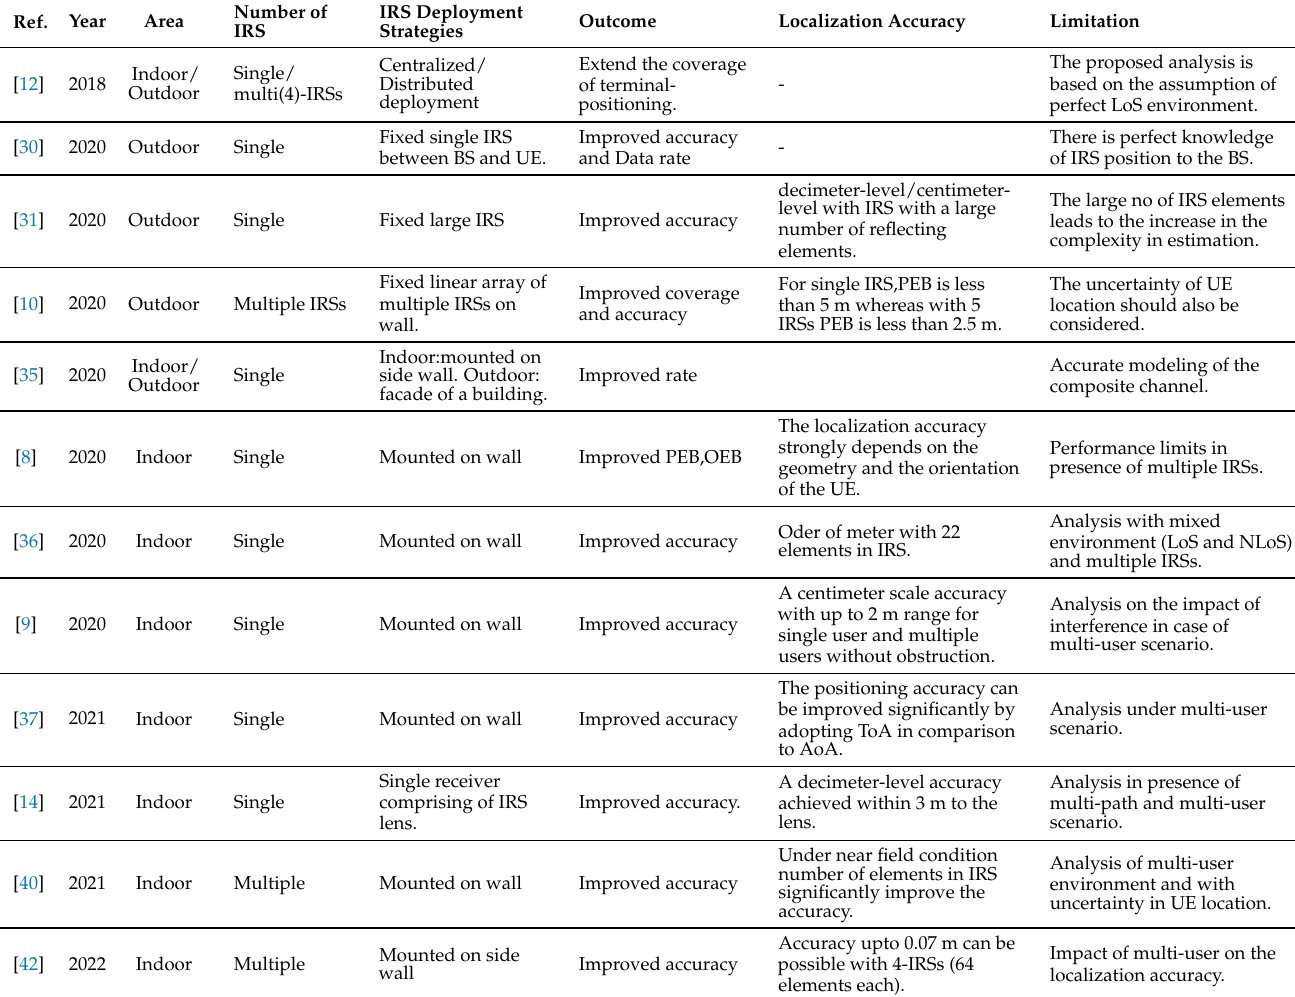
Table 2. Summary: IRS-assisted Indoor/Outdoor Localization